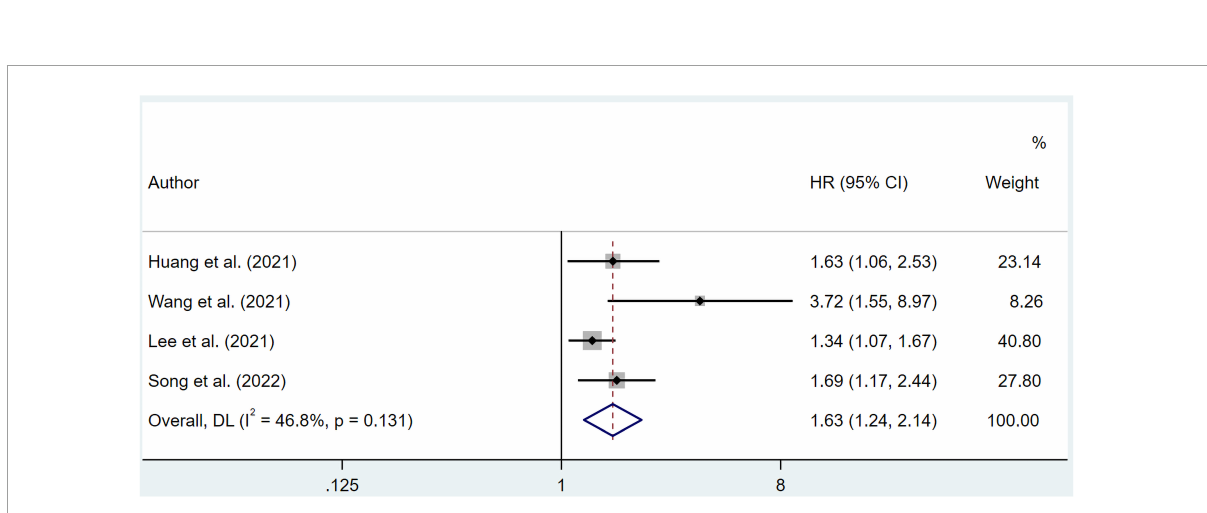
FIGURE4 Forest plots showing pooled HR with 95% CI of disease-free survival under multivariate regression model. X-axis indicated hazard ratio (HR). Weights are from random-effects